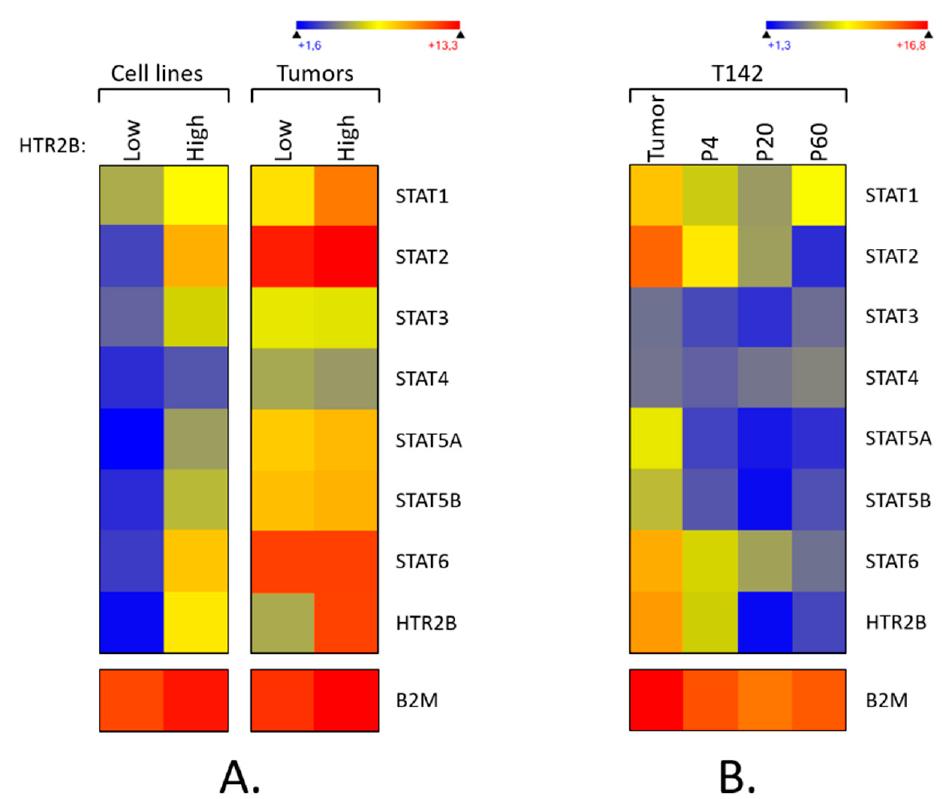
Figure 1. Expression of STAT genes in uveal melanoma. ( A ) Heatmap representation of all the STAT genes expressed by UM cell lines or the primary tumors from which they have been cultured. Data show the average of the individual transcriptome profile extracted from UM cell lines that express either low (T97, T108, T111, T128, T131, T132 and T143 cell lines) or high levels of HTR2B (T98, T142, T151 and T157 cell lines), or from primary tumors with either low (tumors 140, 149, 154 and 157) or high HTR2B levels (tumors 138, 139, 141, 142, 147 and 151). A dark blue color corresponds to a very low level of expression, whereas high levels appear in yellow/red. Moderate to high levels of all STAT genes except STAT4 are observed in UM cell lines with high levels of HTR2B but not in UM cells with low expression of HTR2B . In UM primary tumors, only STAT1 expression is considerably reduced in tumors with low HTR2B levels. ( B ) Heatmap representation of all STAT genes expressed by the UM primary tumor 142 (tumor) and its derivative cell line T142 cultured at passages P4, P20 and P60 as determined by DNA microarrays. As for HTR2B , expression of STAT genes, which is elevated in the primary tumor 142, is rapidly lost with cell passaging in the derivative T142 UM